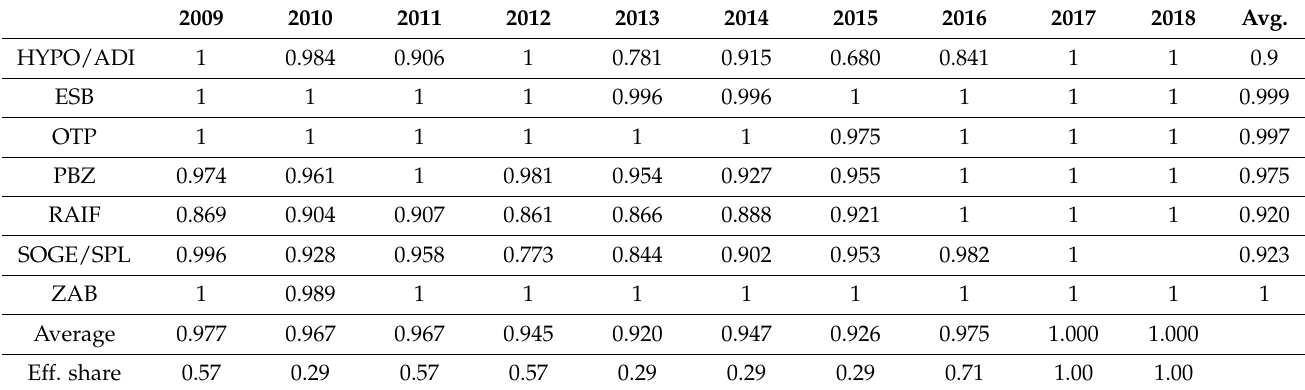
Table 2. The efficiency scores of large banks during 2009–2018 (BCC model).